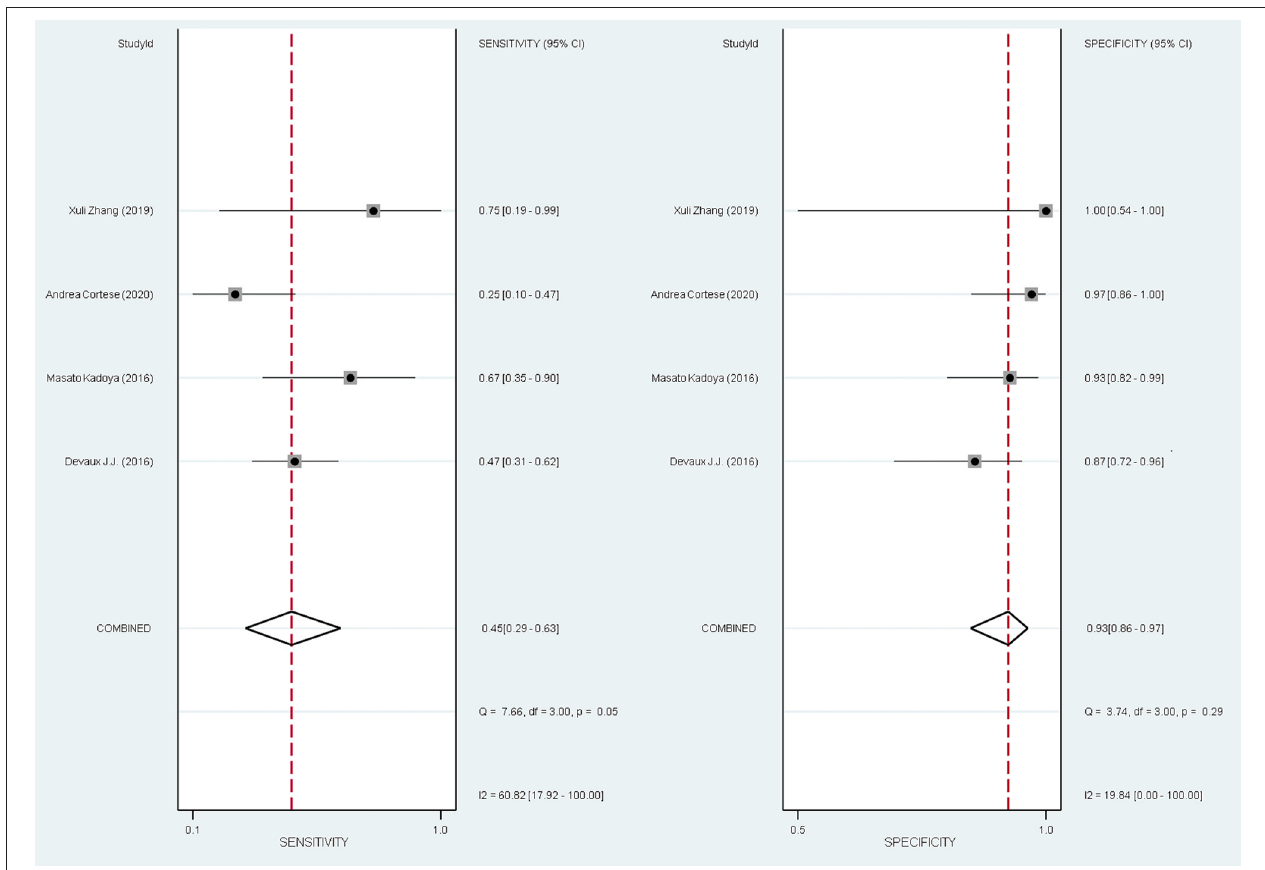
FIGURE 6 | The forest plot of anti-NF155 autoantibody test in detection of a subtype of